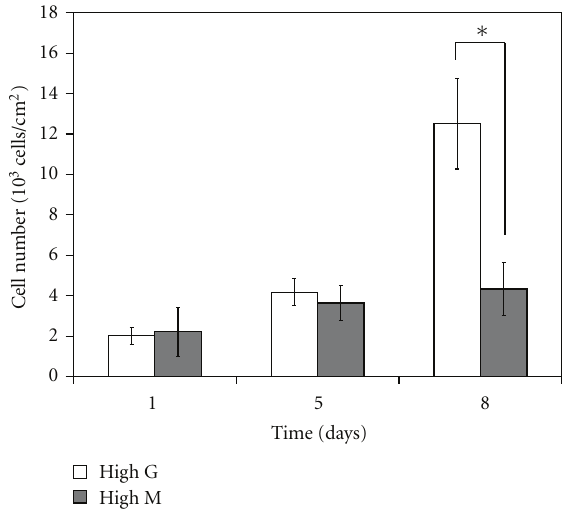
Figure 1: Proliferation of NHDF on Fe-alginate films with a high G or high M content. Cells were seeded on Fe-alginate films at a density of 4000 cells/cm 2 , and numbers of attached cells were counted at 1, 5, and 8 days after the start of culture. Error bars indicate standard deviation for n = 5. ∗ P < 0 .